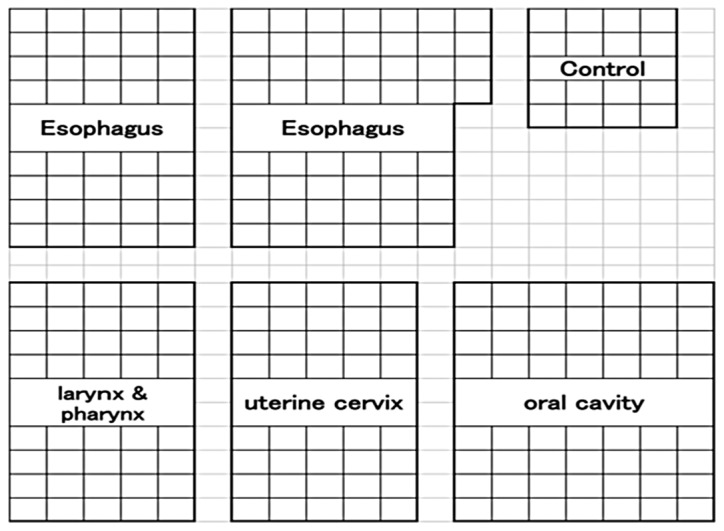
Design of the squamous cell carcinoma (SCC) Ca284 TMA. The layout shows the location of the esophageal, laryngeal and pharyngeal, uterine/cervical and oral cancer.